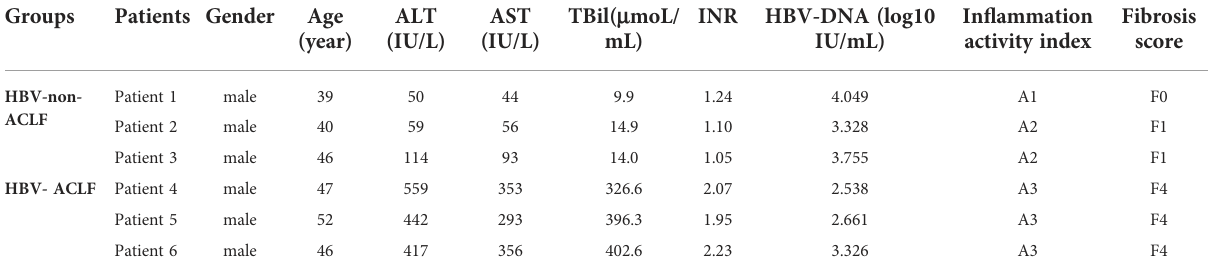
TABLE 1 Clinical characteristics of the two groups of patients.